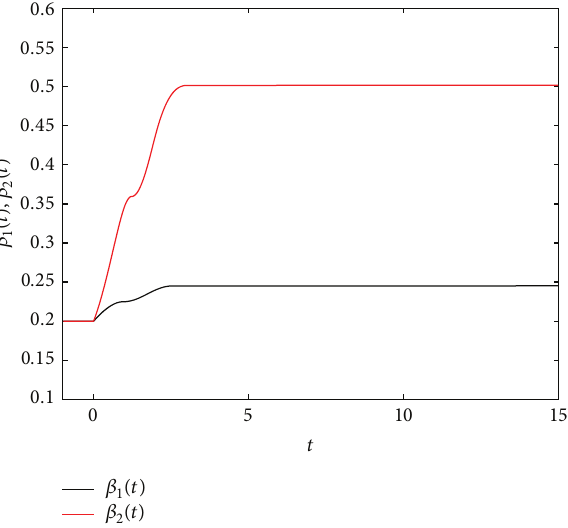
Figure 6: Time response of synchronization error 𝑒(𝑡) = 𝑦(𝑡)−𝑥(𝑡) . 𝑢(𝑡) = −𝐺(𝑦(𝑡) − 𝑥(𝑡)) was utilized to control system (25),